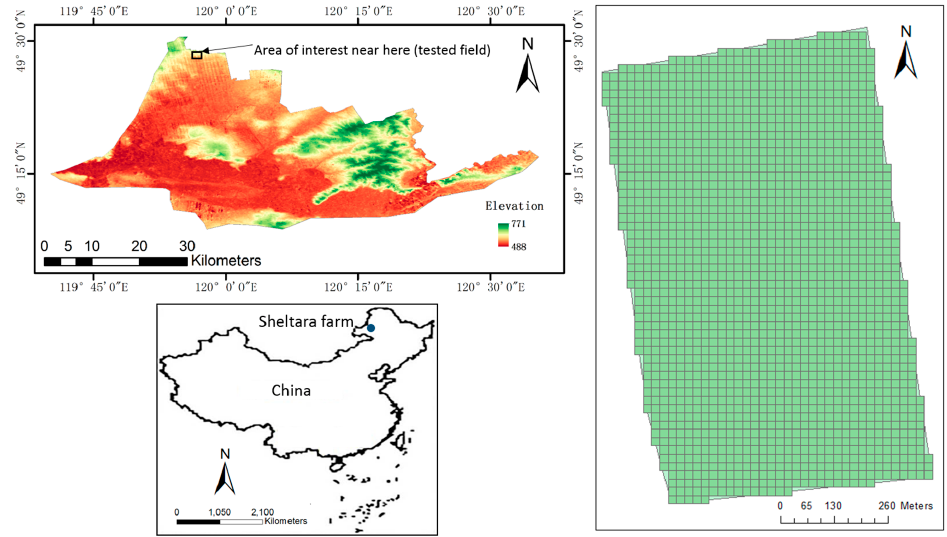
Figure 1. Sheltara farm (left) and the tested farm field (right) for validating the proposed method. Table 2. The dataset characteristics of the tested